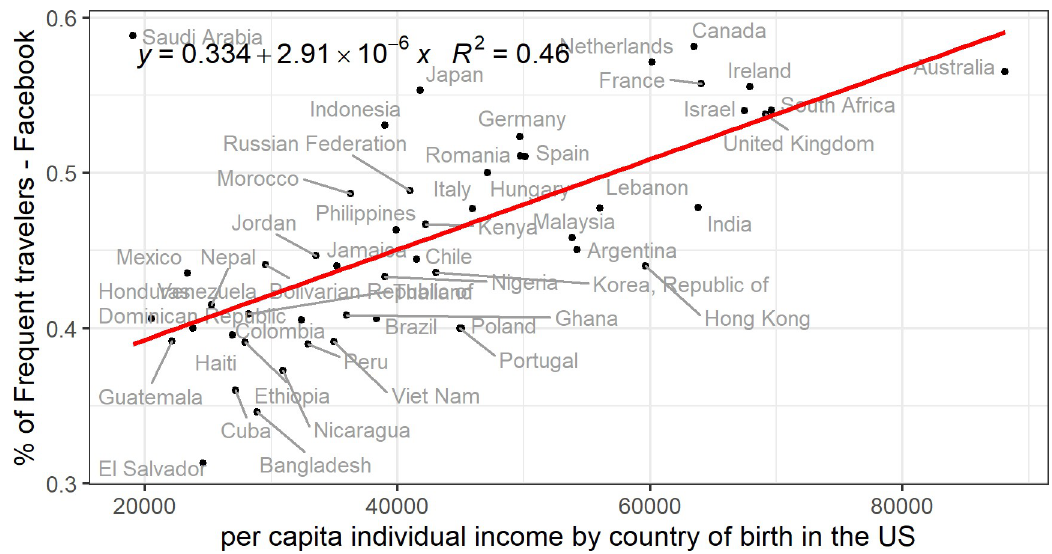
Fig 2. Correlation between income and travelling behaviour. The x-axis shows the per capita individual income of US residents by country of birth, and the y-axis shows the percentage of Facebook users who are frequent travellers by country of previous residence in the